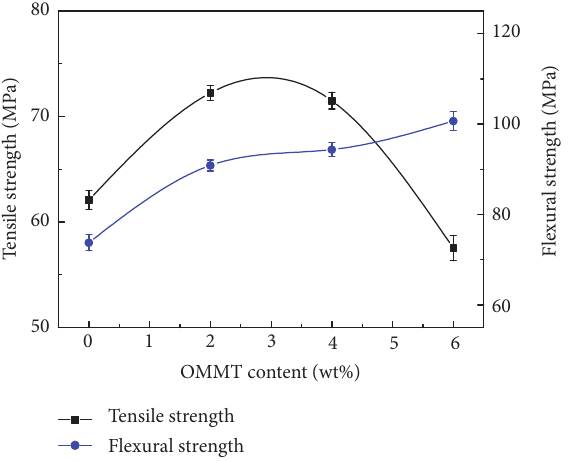
Figure 5: The relation of notched impact strengths and particle size for PPO/PA66 nanocomposites.